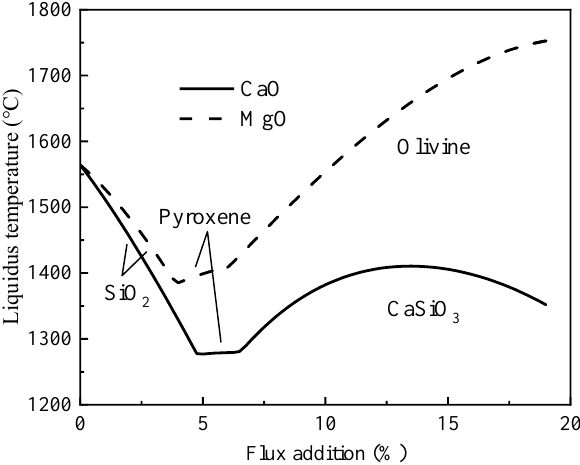
Figure 2. Effect of flux addition on the liquidus temperature of